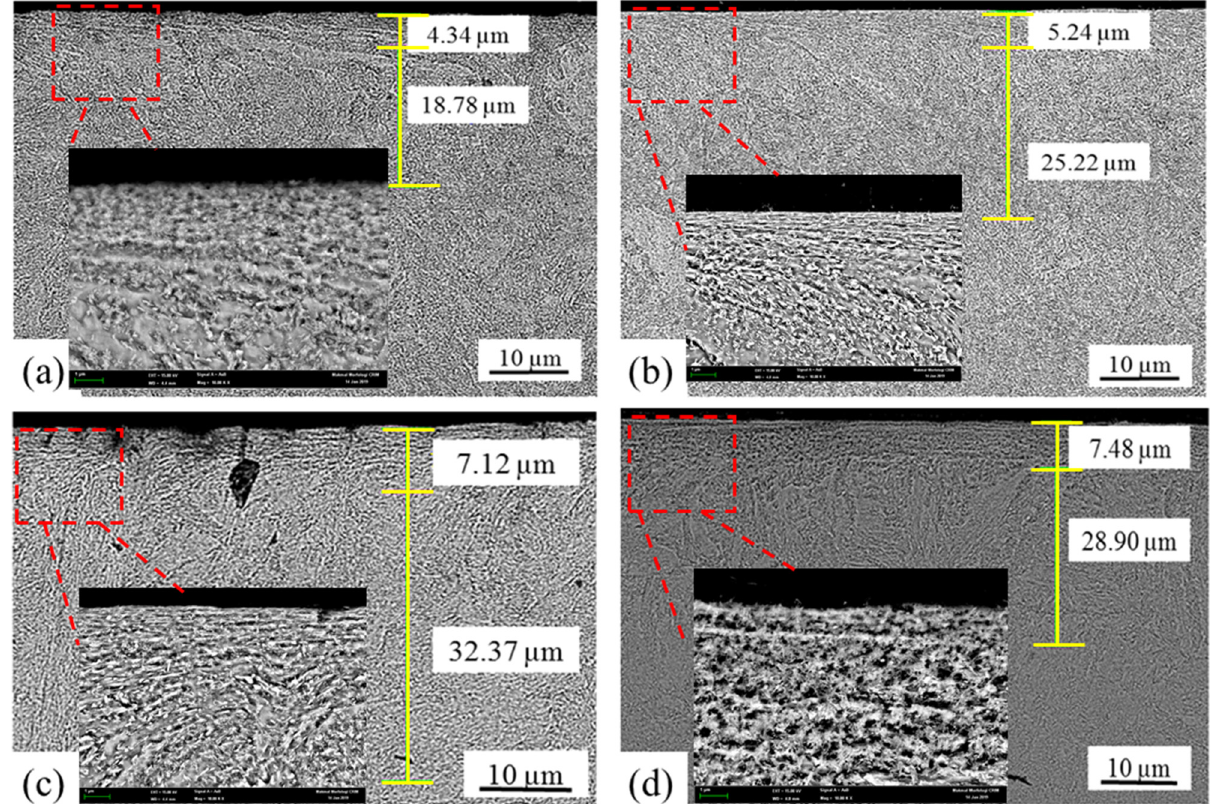
Figure 5: Microstructure beneath the machined surface and machining - a ff ected layer of sample no.: ( a ) 1, ( b ) 2, ( c ) 3, and ( d ) 4.